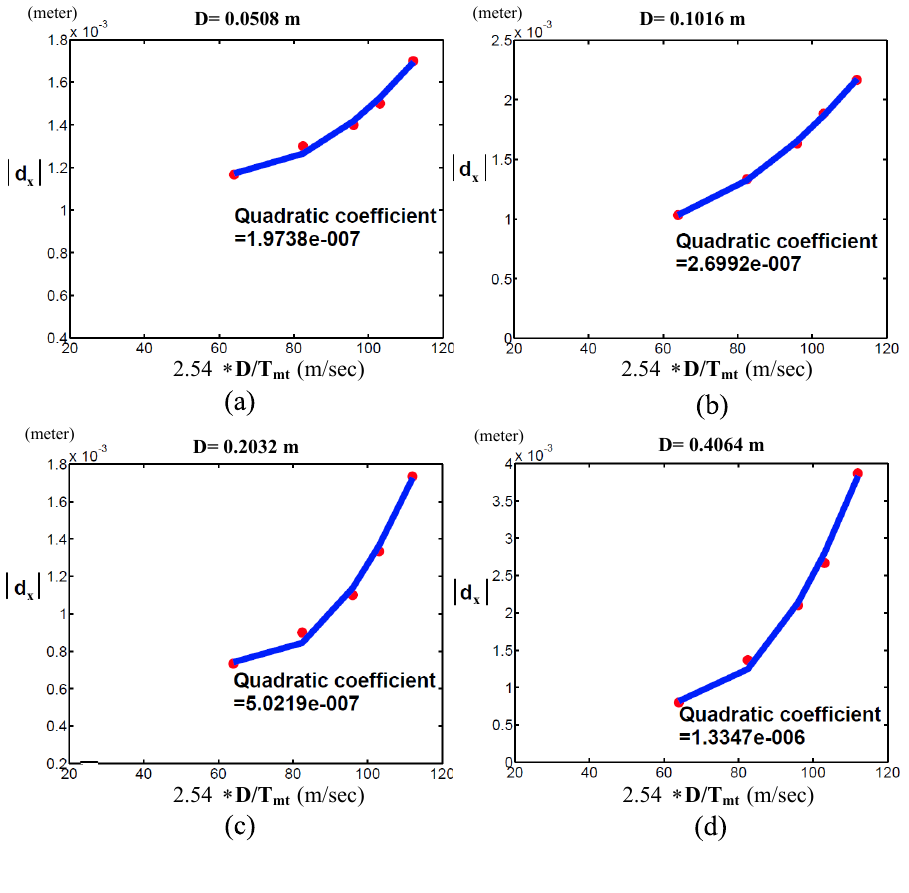
Figure 12. PUMA 260 experimental results of the Cartesian position errors of the end-effector along the x -axis ( d ) with respect to D/T ( a ) D = 0.0508 m; ( b ) D = 0.1016 m; x mt ( c ) D = 0.2032 m; ( d ) D = 0.4064